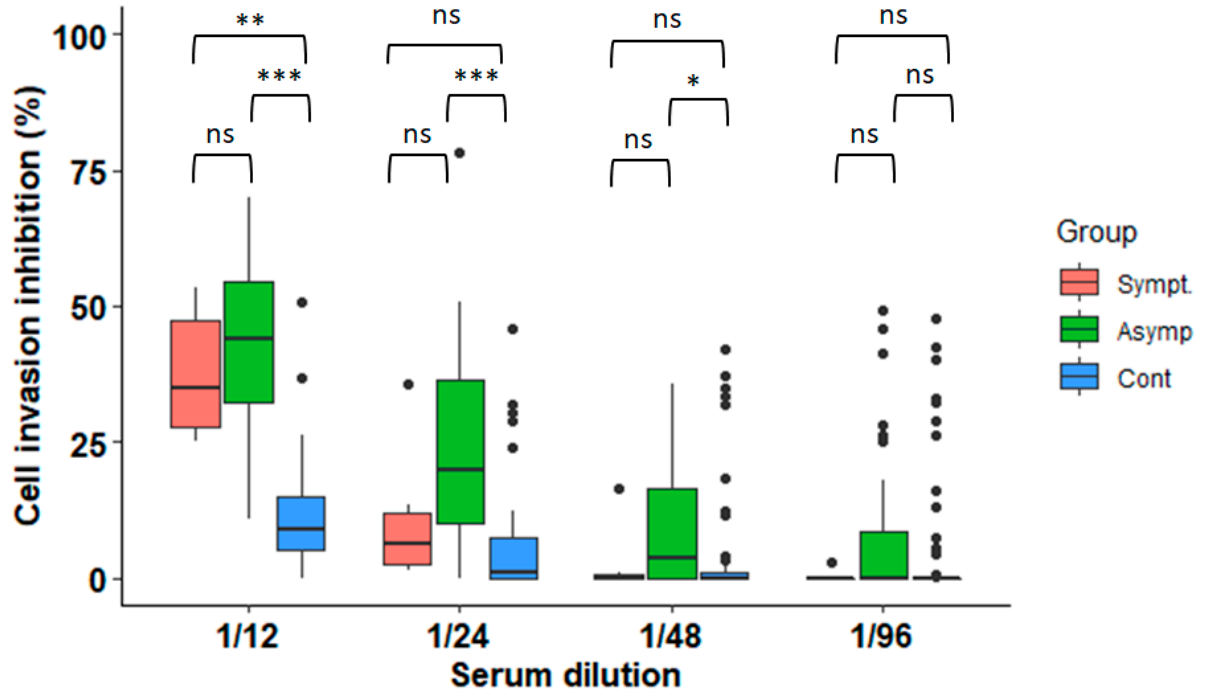
Figure 1. Inhibition of cell invasion after incubation with serum samples from non-infected controls and subjects infected with T. cruzi . (N = 104 samples; pairwise Wilcoxon test with Bonferroni